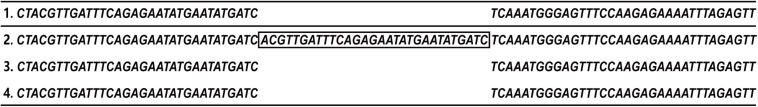
Confirmation of FLT3 gene sequence in cell lines. Partial FLT3 sequences of each cell line (1. FLT3-WT sequence from NCBI; 2. MV4-11 3. HL60 4. KG1a).